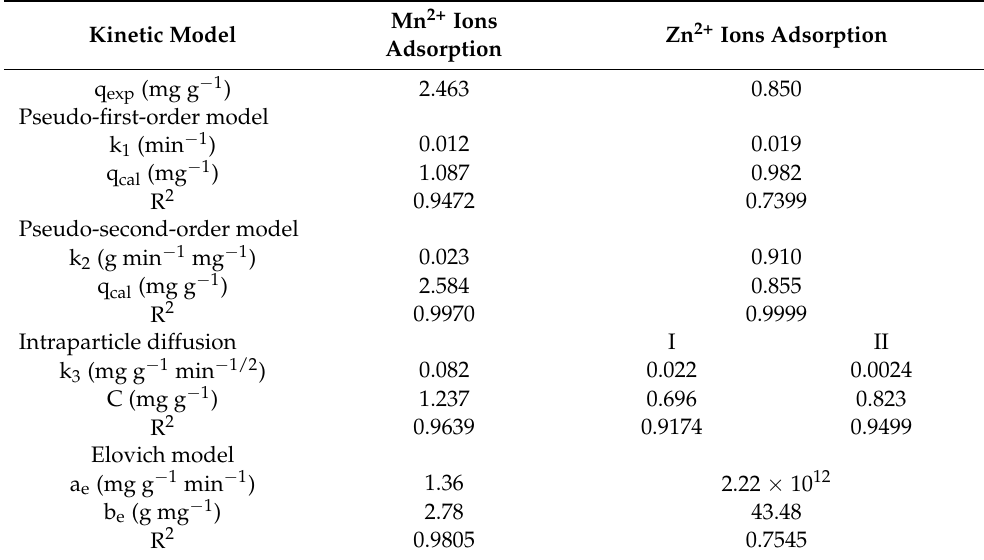
Table 4. Kinetics model parameters and the regression coefficients for metals adsorption by powder Cyprinus carpio